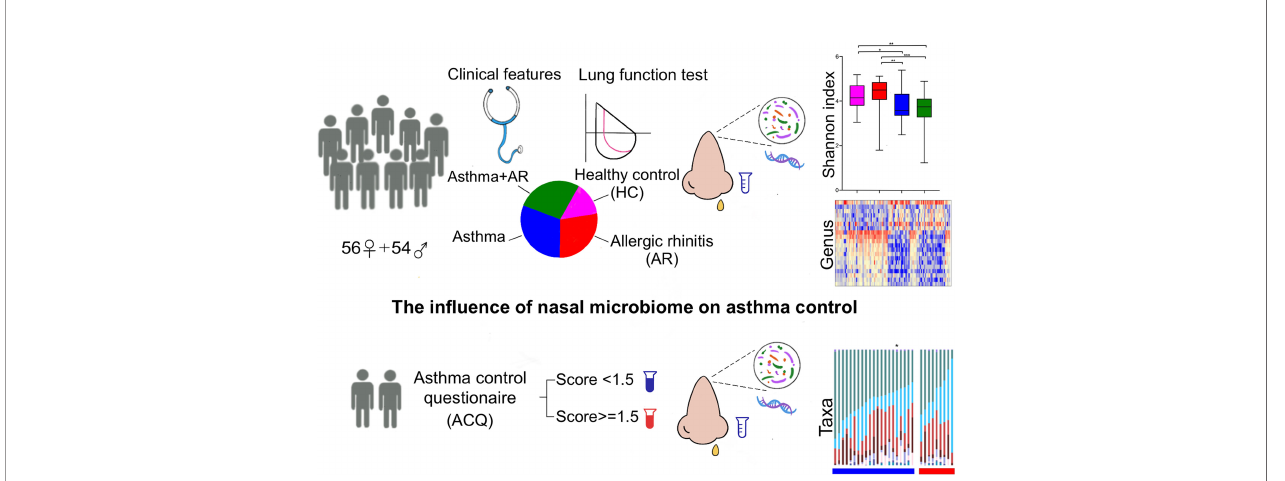
FIGURE 1 | Study design pro fi le. AR, allergic rhinitis; HC, healthy controls; ACQ, Asthma control questionnaire. P < 0.05 was considered as statistically signi fi cant, *P < 0.05, **P < 0.01, *** P < 0.001.